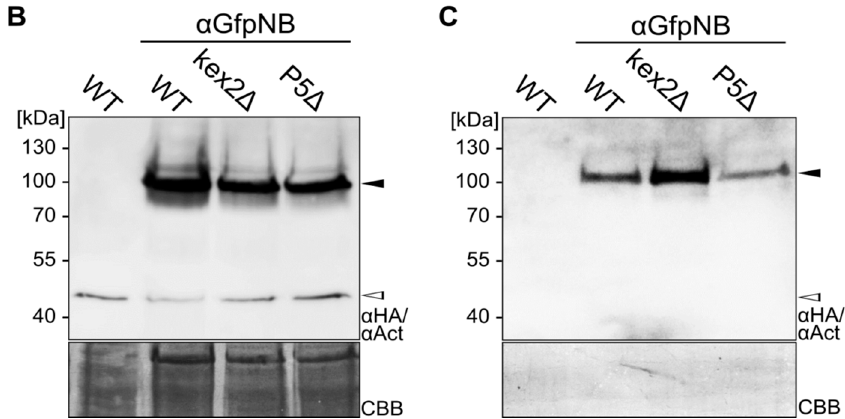
Figure 1. Expression and unconventional secretion of an anti-green fluorescent protein ( α Gfp) nanobody in Ustilago maydis . ( A ) Design of the expression vector for chitinase Cts1-mediated nanobody secretion. Vector backbone pRabX2 carries the ip r region for targeted homologous recombination. The very strong constitutive promoter P oma is used for gene expression. The nanobody is expressed as fusion with a sequence encoding Cts1 and tags for purification and detection. A sequence for a Tobacco Etch Virus (TEV) protease cleavage site is inserted between the two genes. T art , artificial terminator composed of the ubi 1 3 ′ UTR and T nos [24]. Black arrowhead indicates the full-length fusion protein, open arrowhead depicts the actin loading control; ( B ) Expression of the α GfpNB-Cts1 fusion protein in cell extracts (10 μ g) of indicated AB33 (WT) derivatives assayed by Western blot analysis using an α HA antibody. Actin-specific antibodies ( α Act) were used in parallel as loading control. The membrane was stained after detection with Coomassie Brilliant Blue (CBB); ( C ) Detection of unconventionally secreted α GfpNB-Cts1 fusion protein in precipitated cell-free culture supernatants (volumetric normalisation) of indicated AB33 (WT) derivatives assayed by Western blot analysis using an α HA antibody. α Act antibodies were used to exclude cell lysis. The membrane was stained with CBB after detection. Black arrowhead indicates the full-length fusion protein, open arrowhead depicts the actin cell lysis control.